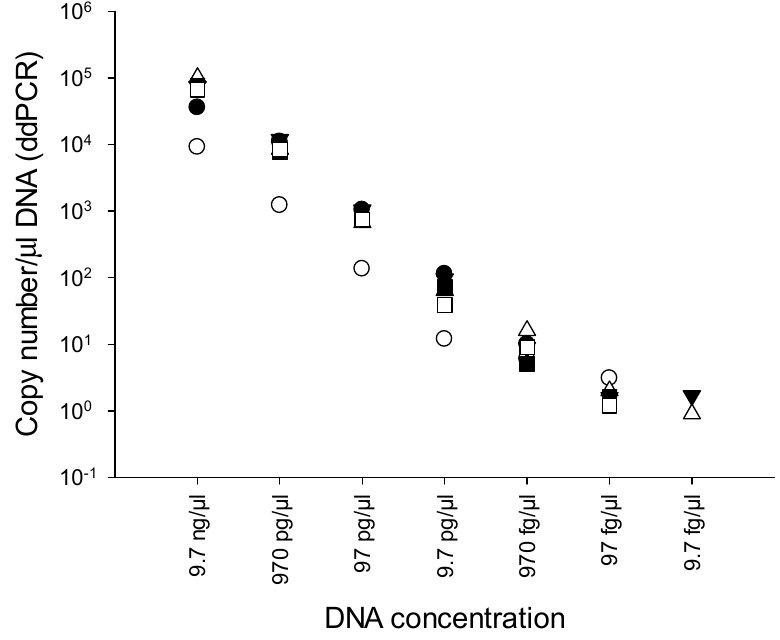
Figure 2. Limit of detection (LOD) of the PMAxx-ddPCR assay. DNA concentrations of the DNA samples (97 ng/ µ L) were spectrophotometrically determined at undiluted DNA samples (97 ng/ μ L) were spectrophotometrically determined at A260.